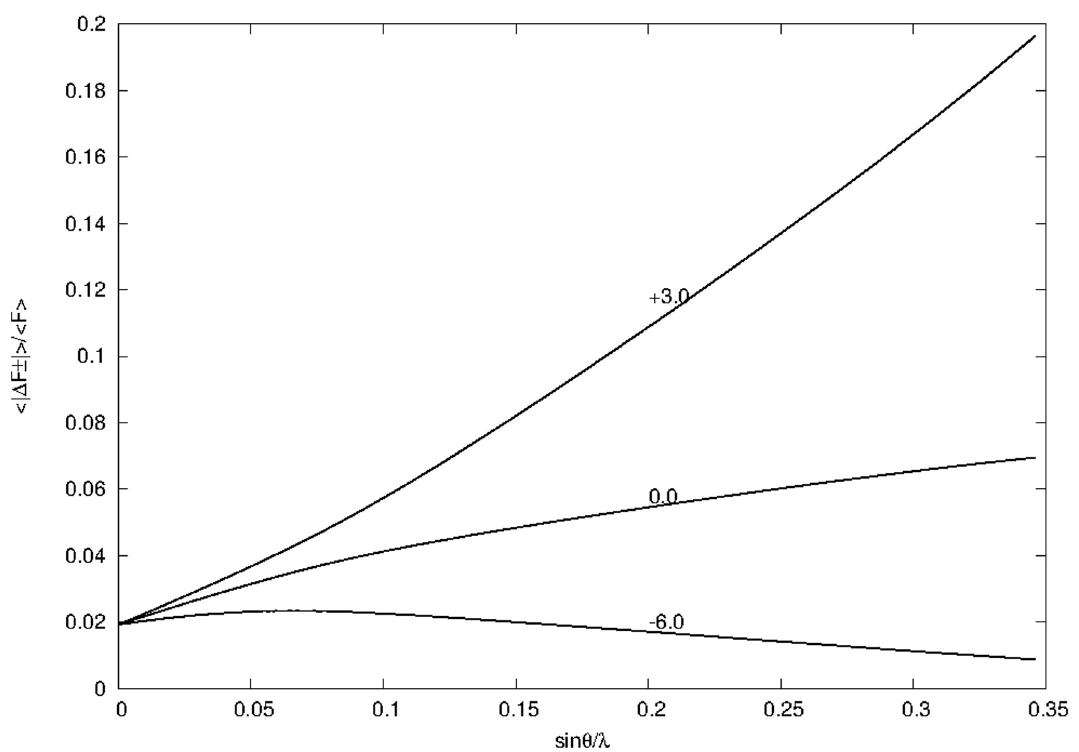
Figure 13. Plot of the calculated anomalous signal as a function of resolution and including the term for ∆ B representing the relative atomic displacement factor for phosphorus atoms in relation to non-anomalously scattering